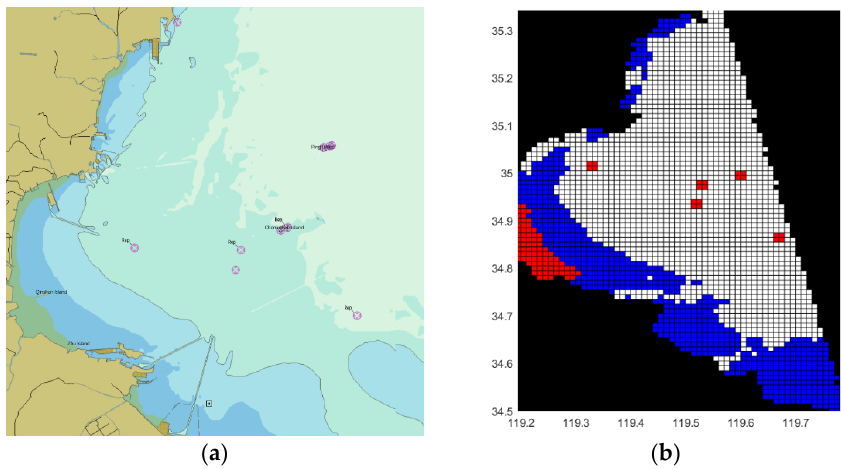
Figure 3. Validation of water level.